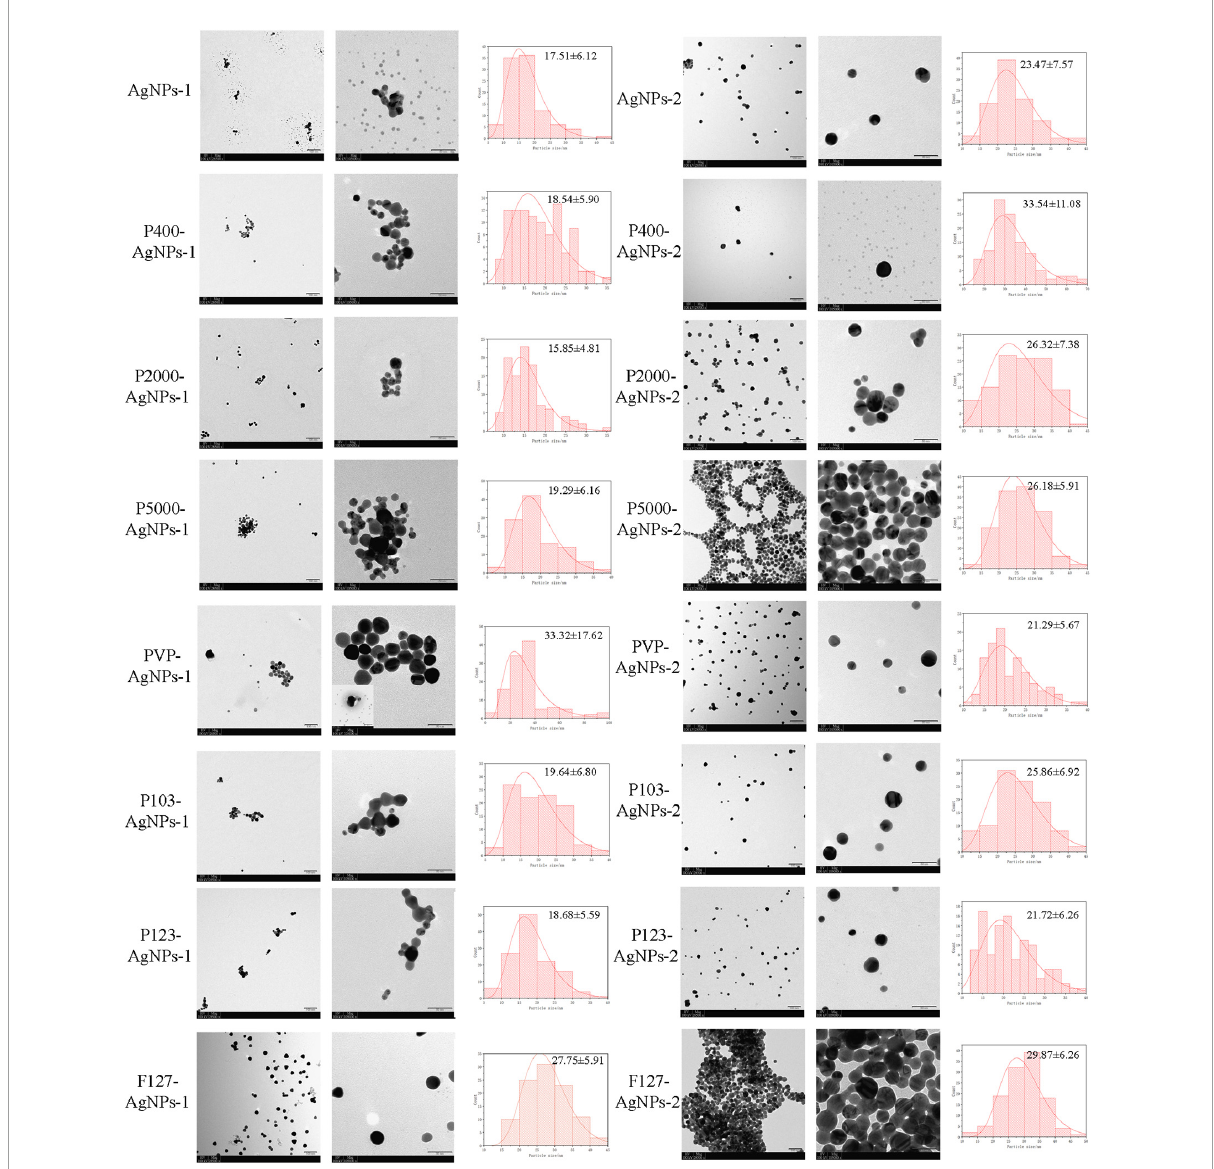
FIGURE2 TEM images of AgNPs-1/2 and P-AgNPs-1/2, along with the histograms of nanometer size distribution (ImageJ). The scale bar values for each pair of images are 100 nm (left) and 50 nm (right)